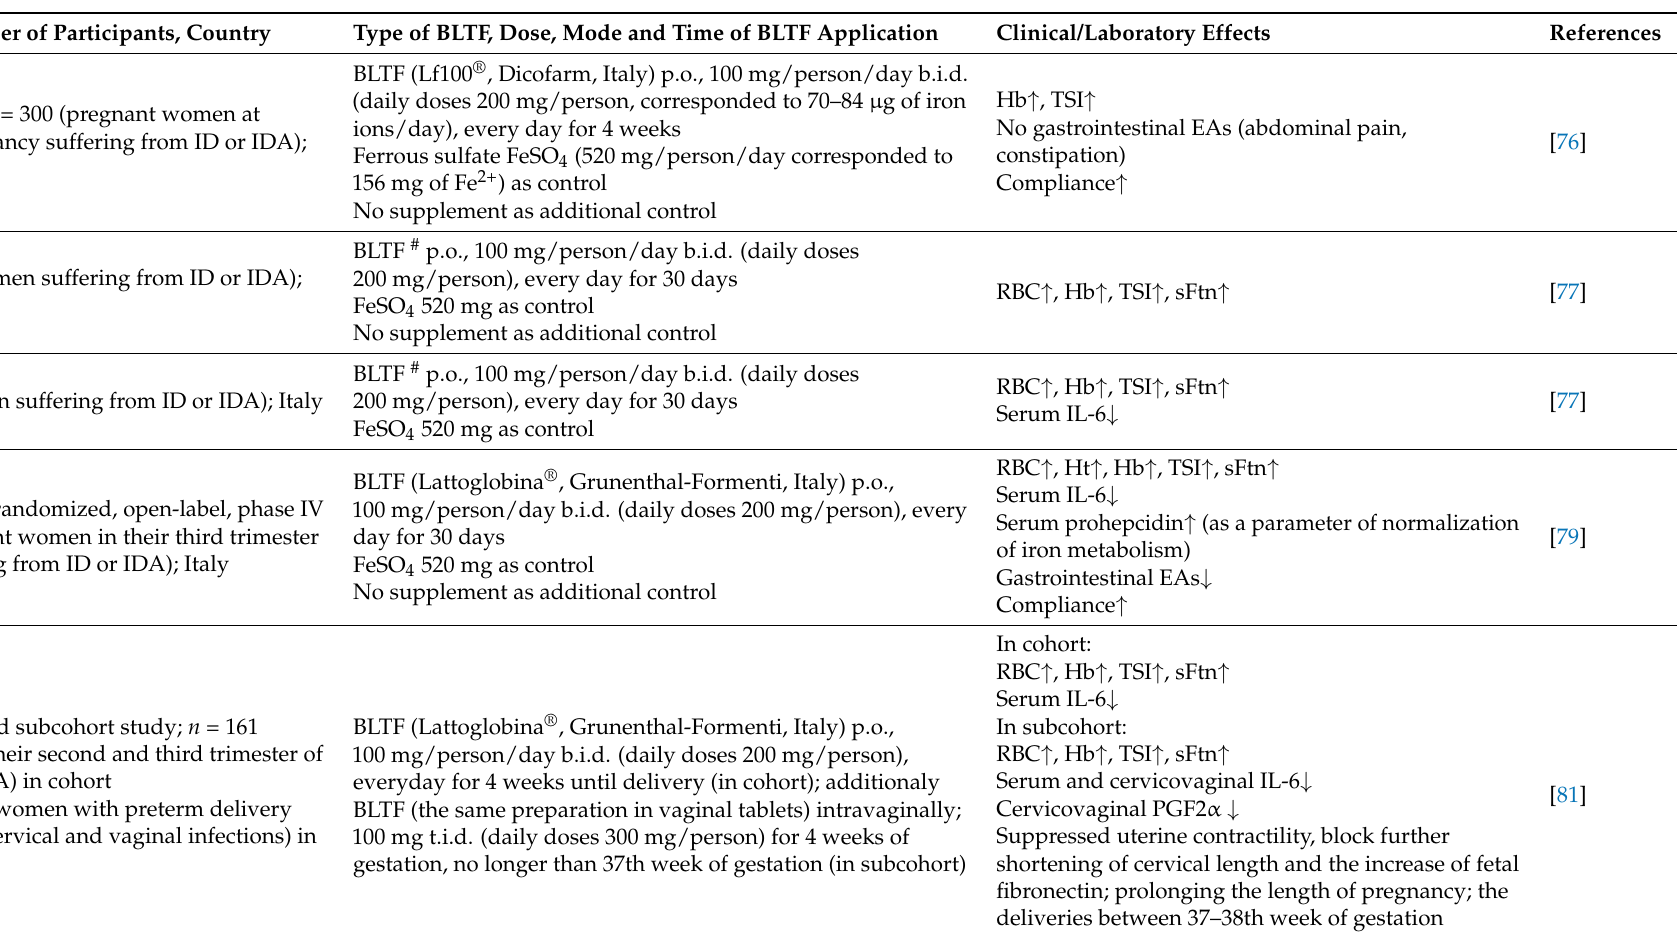
Table 1. Clinical studies with BLTF in therapy of pregnant women suffering from